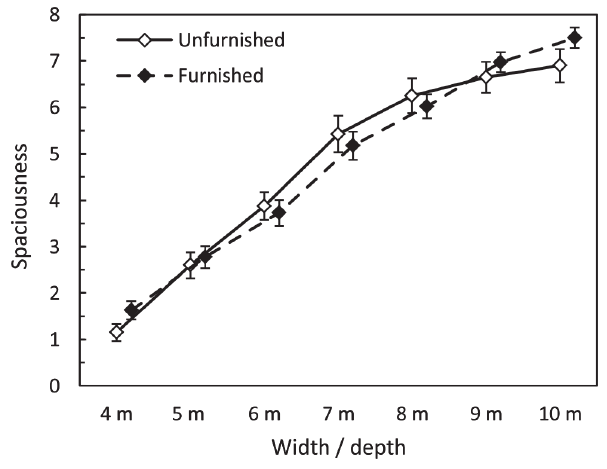
Figure 10. Experiment 2: Mean spaciousness judgments as a function of furnishing and width/depth. Error bars show 6 1 SEM of the 40 subjects in each condition.